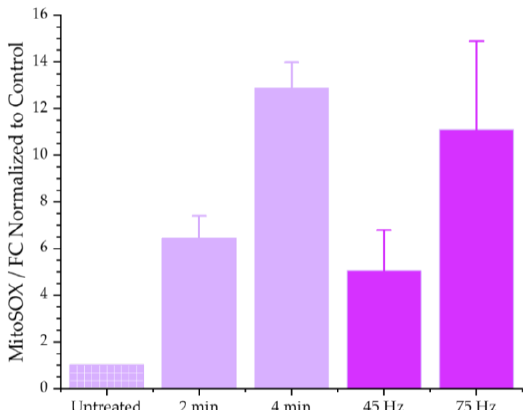
Figure 3. Mitochondrial O 2 − production in Jurkat T lymphocytes in response to plasma treatment. COST-Jet (2 and 4 min) and nspDBD (45 and 75 Hz) induced higher and comparable magnitudes of oxidative stress relative to the untreated control cells. This experiment was repeated once in triplicate. The data plotted represent the mean and standard deviation.